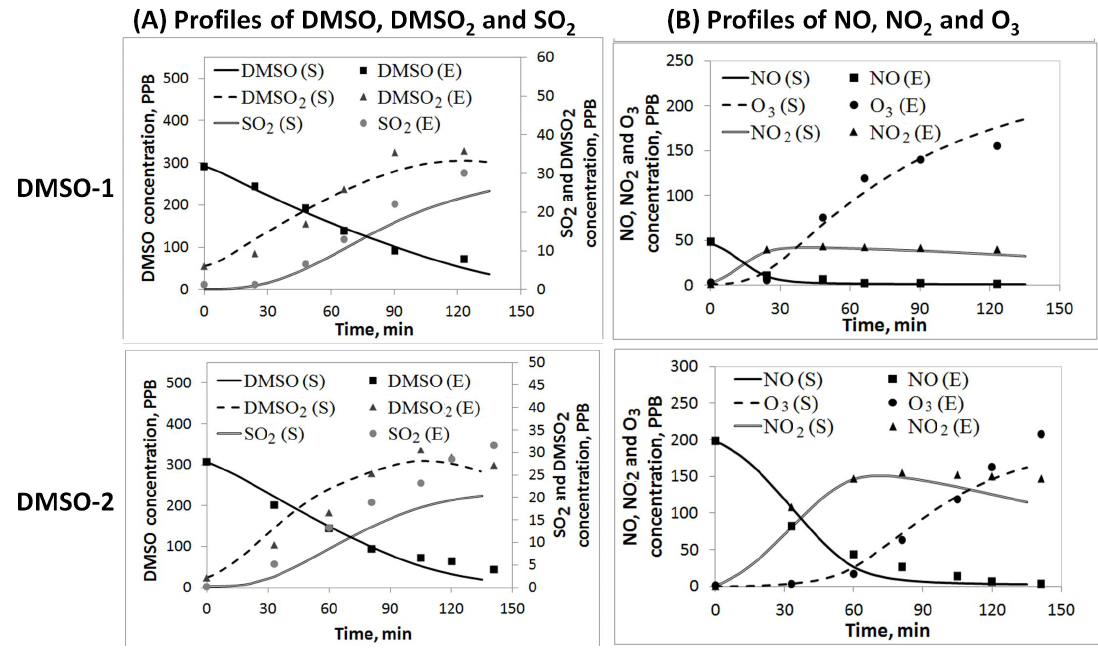
Fig. 1. Time profiles of DMSO, DMSO 2 , SO 2 , NO x and O 3 for the photooxidation of DMSO in the presence of NO x (Exp DMSO-1 and DMSO-2 in Table 1). “E” denotes the experimentally observed concentrations of chemical species and “S” for those simulated using the kinetic model. The decay of DMSO was not corrected for the wall loss and chamber